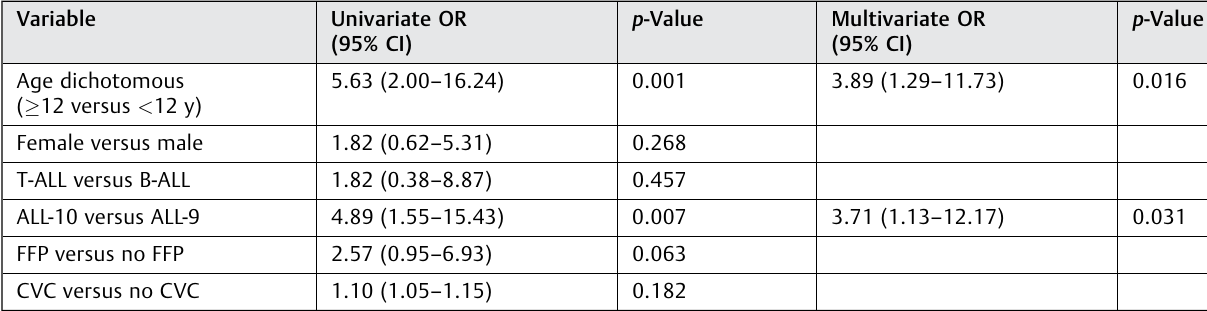
Table 2 Logistic regression analysis for risk of VTE; univariate and multivariate analyses Variable